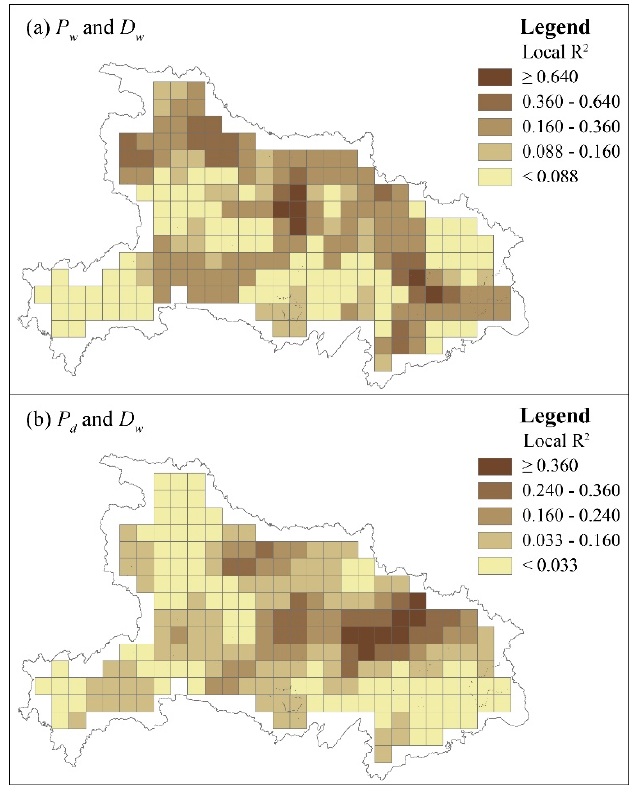
Figure 4. Choropleth maps of the local R 2 distribution at the unit level, ( a ) P w and D w ; ( b ) P d and D w .